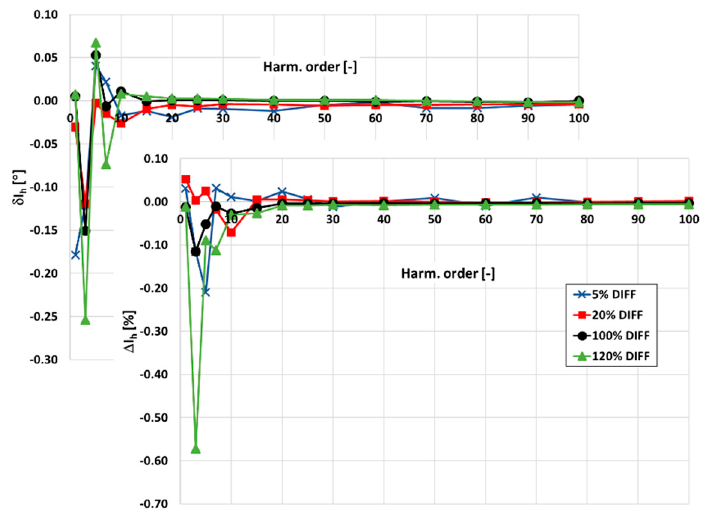
Figure 13. The differences in values of current and phase errors at harmonics measured between class (50 Hz) 0.5 and 0.2 CTs 100 \ 1 A and for each CT in the condition of ampere-turns.